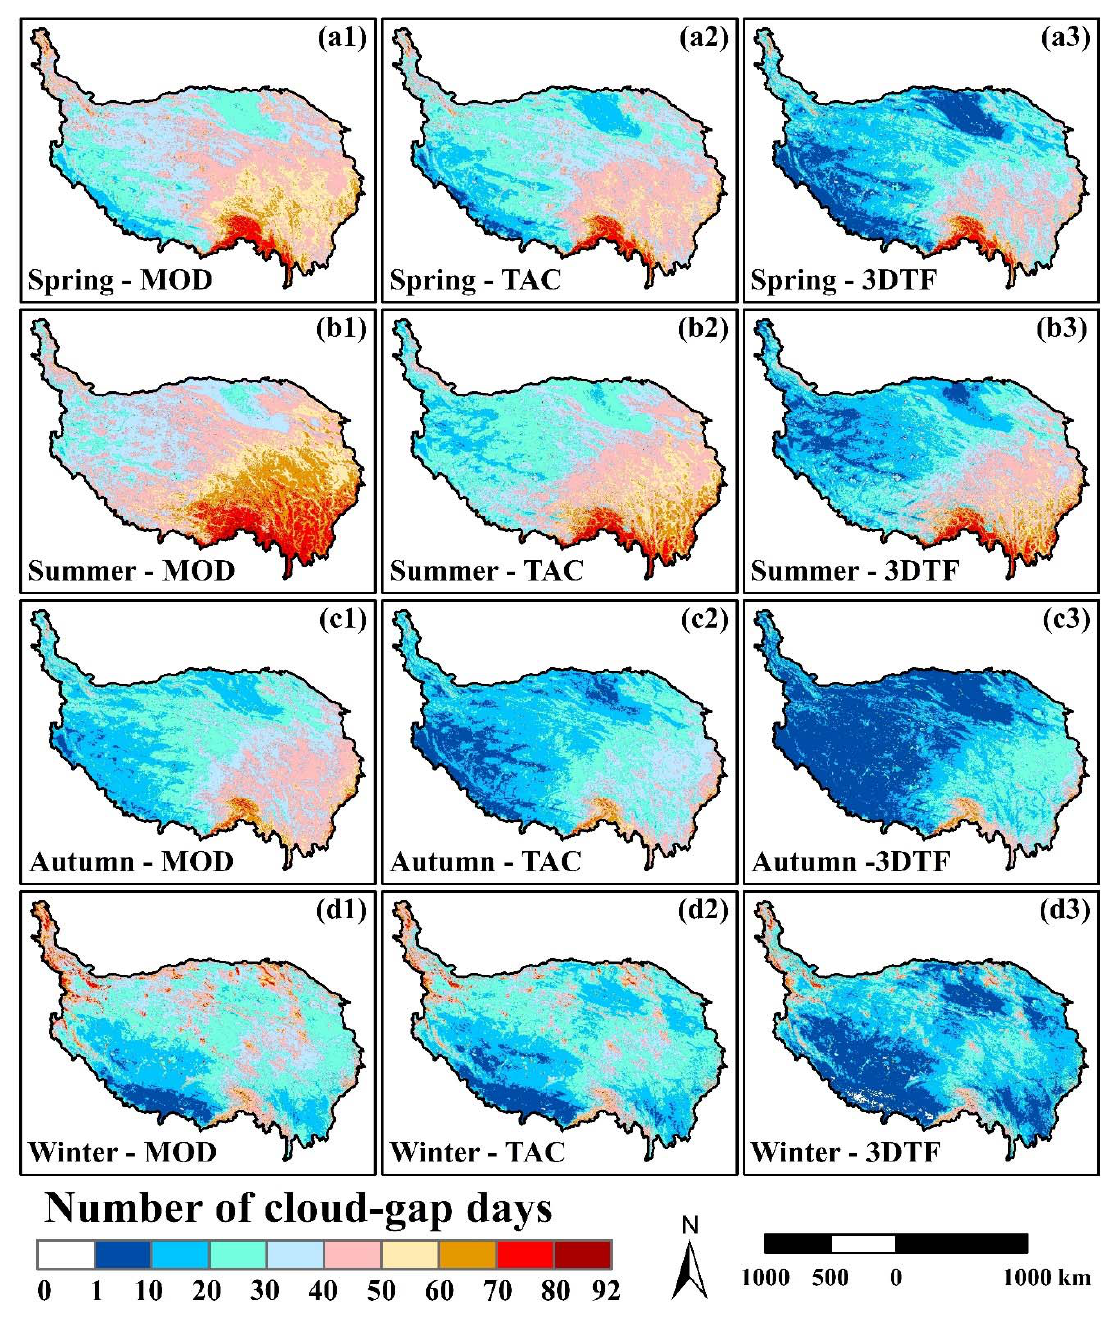
Figure 11. Seasonal average number of cloud-gap days (CGDs) based on di ff erent cloud removal methods. The left column refers to the MOD product, the middle column refers to the TAC product, and the right column refers to the 3DTF product. ( a ), ( b ), ( c ), and ( d ) refer to spring, summer, autumn, and winter, respectively.